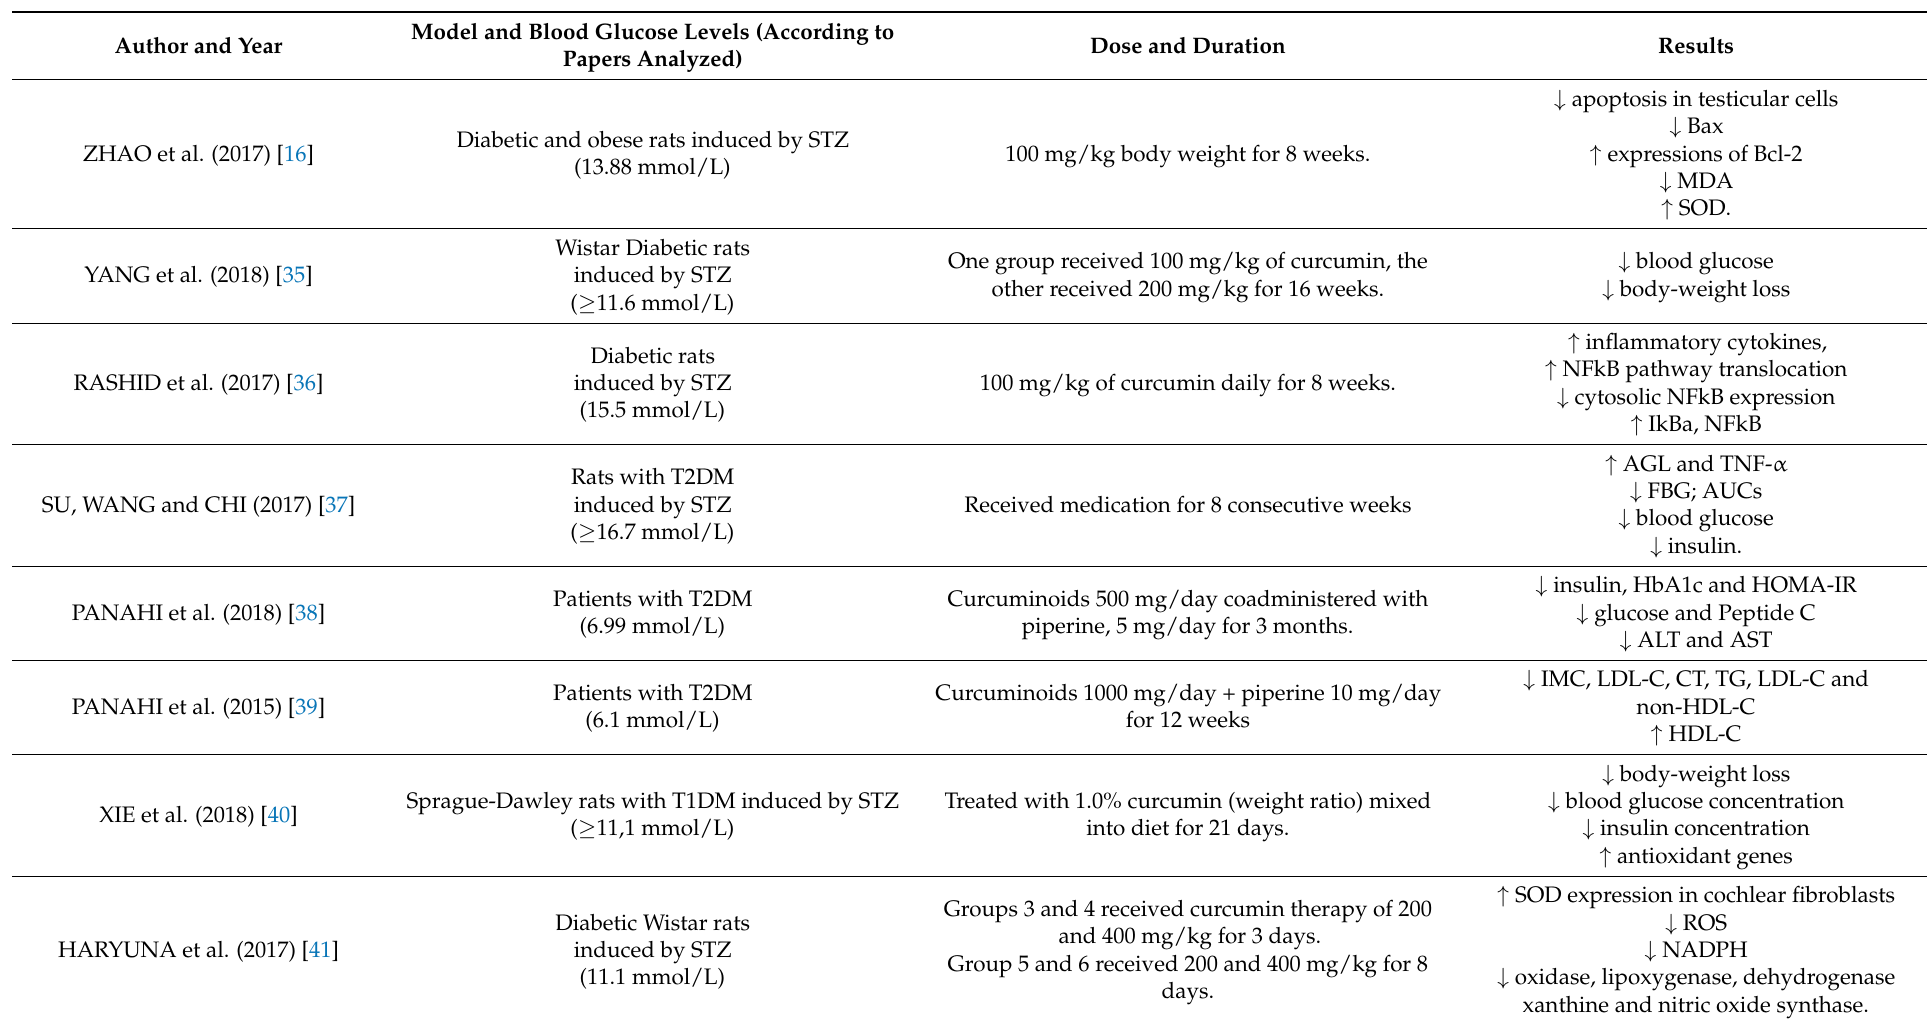
Table 1. Articles selected with human and/or experimental models with different types of diabetes (Type 1 diabetes mellitus and Type 2 diabetes mellitus) submitted to turmeric supplementation and/or associated with physical exercises. Papers were analyzed and selected according to predetermined inclusion